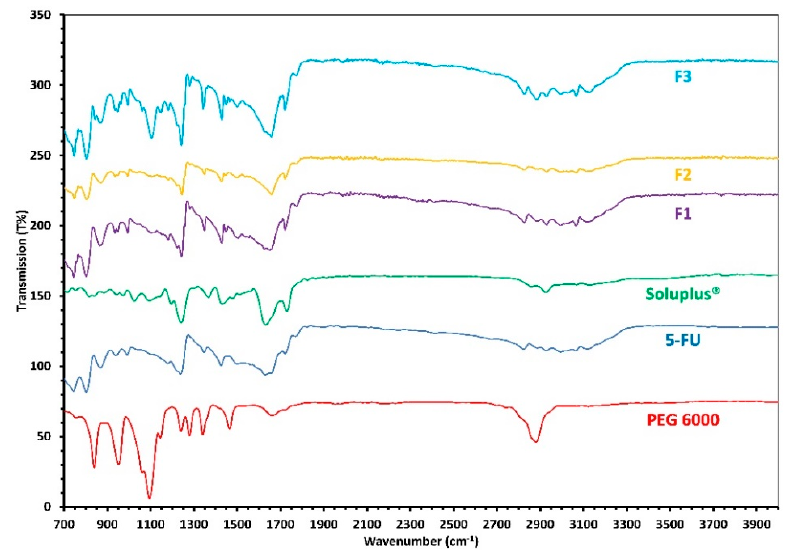
Figure 7. FTIR spectra of bulk materials and formulations F1, F2, and F3.